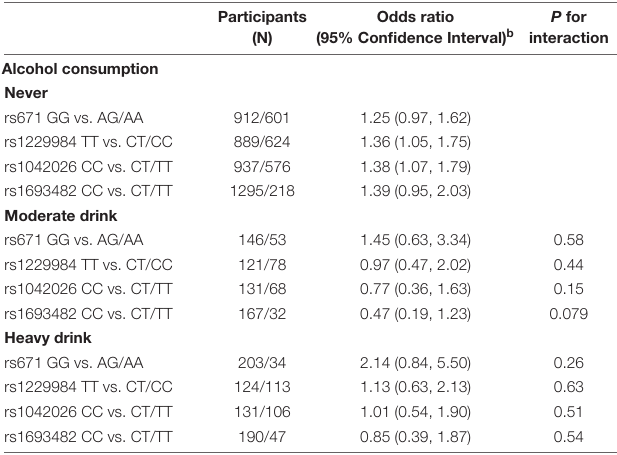
TABLE 3 | The association of ALDH2 rs671 polymorphism with cognitive impairment stratified by alcohol consumption and fresh fruit consumption.